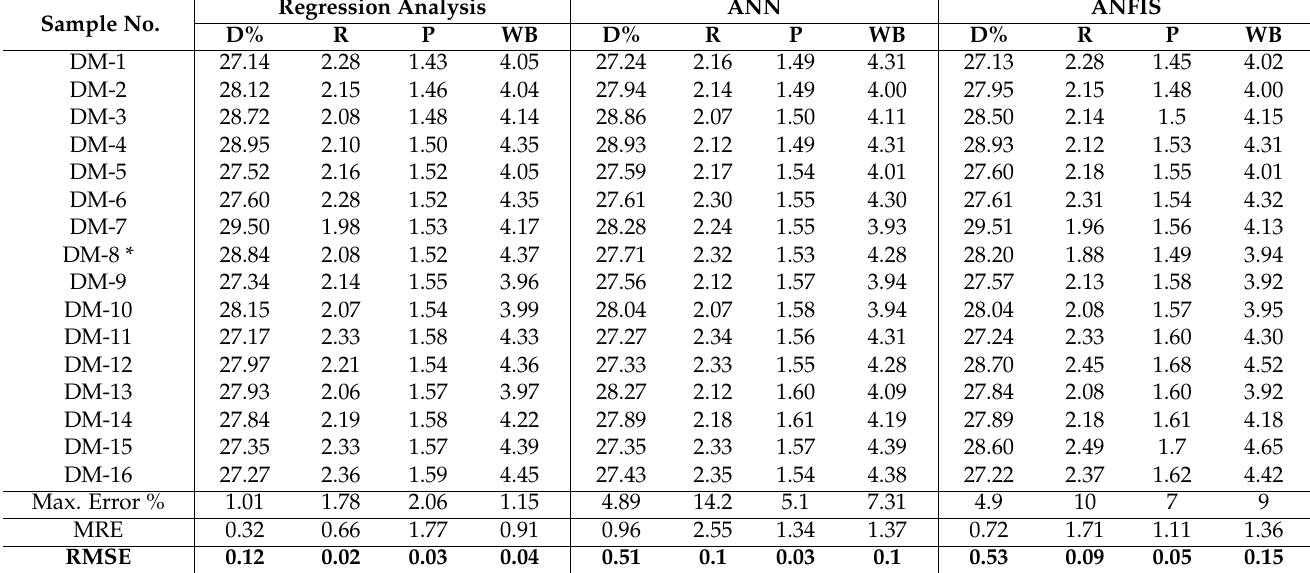
Table 9. Tabulation of results obtained from developed prediction models within the input design range. Sample No.